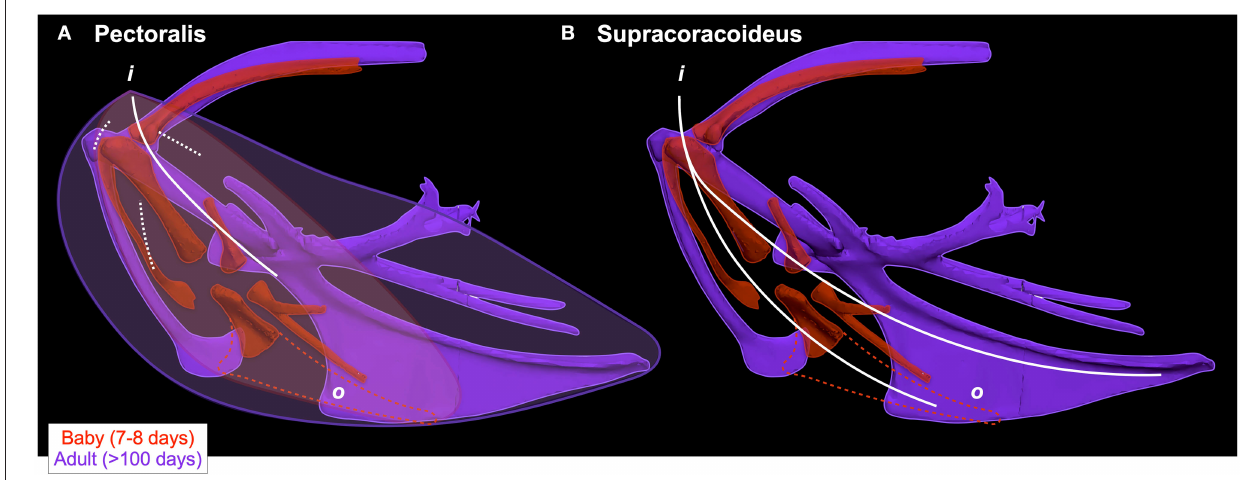
FIGURE 9 | Different skeletons underlie similar muscles. In spite of underlying changes in skeletal morphology, the pectoralis (left) and supracoracoideus (right) maintain similar paths (indicated by white lines; o = origin, i = insertion) through ontogeny because changes in one bone are offset by changes in others. When baby and adult chukars are aligned by the vertebral column (i.e., notaria in same position and orientation; not shown for clarity of other structures) rather than by the coracosternal joint (as in Figure 2 ), it becomes clear that ontogenetic shifts in coracoid angle ( Figure 4 ) are counteracted by changes in furculo- and scapulo-coracoid angles, such that the glenoid, furcula, and scapula maintain similar positions relative to the vertebral column. As the coracoid changes orientation and positions the growing sternum more caudally, the furcula and cranial portion of the keel expand and maintain the cranial origins of the supracoracoideus and especially the pectoralis. (A) Though the pectoralis has a very broad origin on multiple bones, the bulk of the muscle is concentrated cranially in adult birds and muscle fibers converge near the shoulder joint, resulting in similar paths in babies and adults. Due to its large size and complex architecture, this muscle is extremely challenging to model. The path shown here was determined by tracking the central tendon (solid white line) and fibers (dashed white lines) in dissected adult birds and overlaying these paths onto the skeleton; though the central tendon is not clearly defined in immature birds, muscle fibers appear to be oriented similarly to those of adult birds. Paths were confirmed by elevating and depressing the wing of a deceased bird and observing fiber orientations. (B) The supracoracoideus more closely tracks the sternum and coracoid but is constrained by the triosseal canal, similarly causing muscle paths to converge near the shoulder joint. White lines show the path of the pectoralis (left; solid = central tendon, dashed = fibers) or the supracoracoideus tendon (right; this tendon passes medial to the shoulder joint through the triosseal canal, but is shown so that the entire pathway is visible); red or purple lines show the approximate outline of the pectoralis muscle. Baby and adult aligned by the vertebral column, showing that (i) the glenoid does not change position, (ii) the scapula and furcula have similar orientations in spite of different coracoid orientations, and (iii) the keel in baby birds is functionally equivalent to the interosseous membrane between the sternum and furcula in